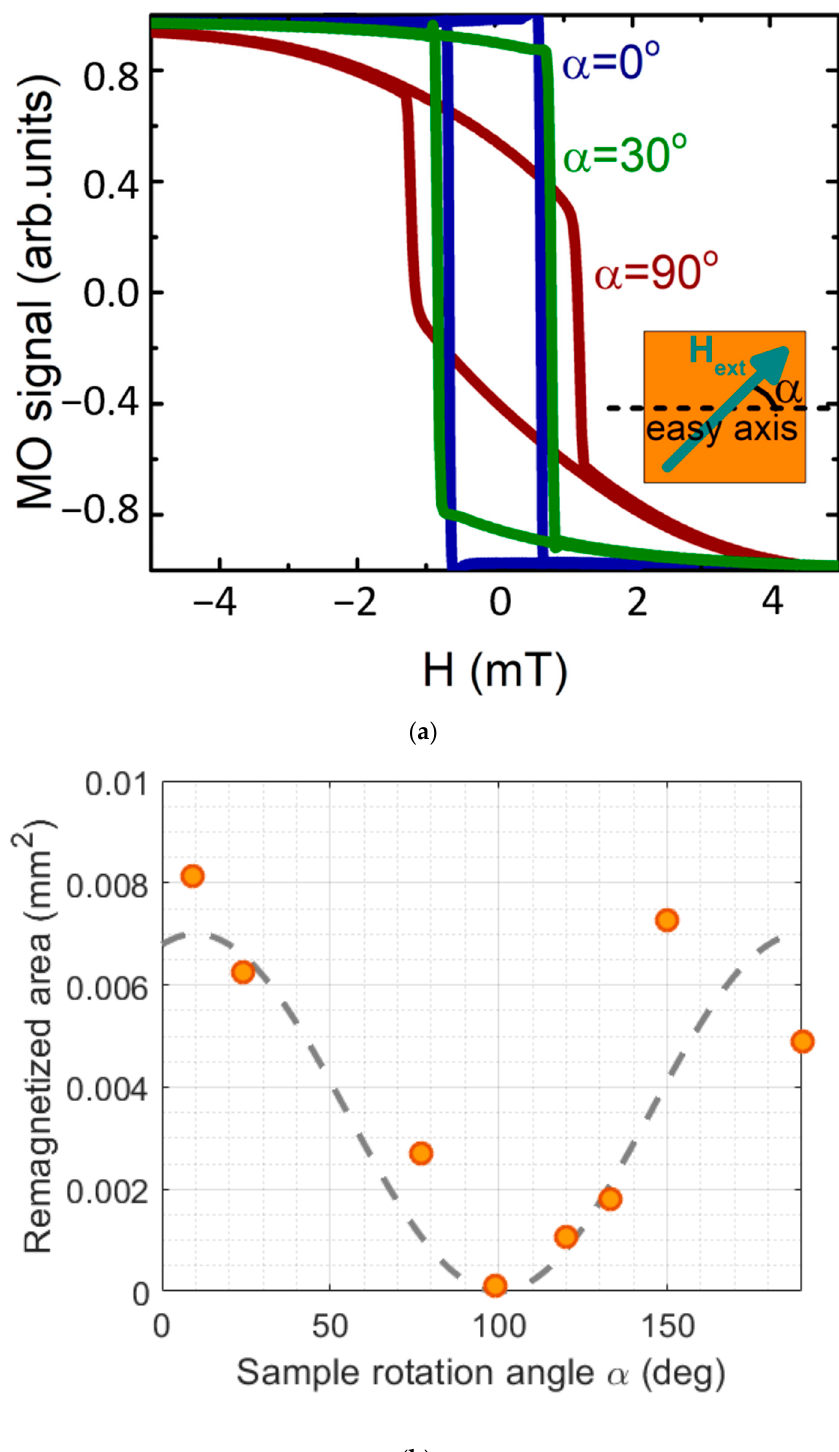
Figure 3. In-plane anisotropy of GdFeCo magnetization switching. ( a ) Hysteresis loops for different angles 𝛼 describing relative orientations of applied external magnetic field H and easy axis of GdFeCo film. The inset shows the studied configuration. ( b ) Dependence of the femtosecond pulse-assisted remagnetized area on the orientation of the initial magneti- zation (orange dots). The gray line is a guide to the eye and shows cos 2 dependence.